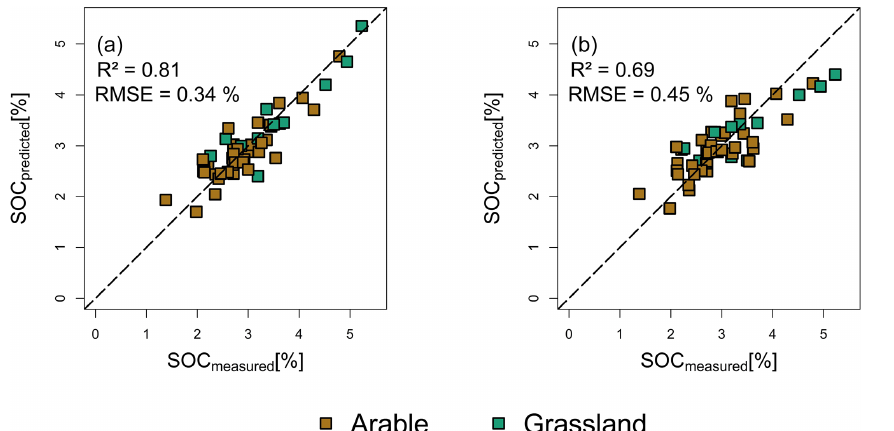
Figure 6. Predicted vs. measured content of SOC of soil samples from the DCS cluster; predictions based on the local model (a) and the global model (b) .